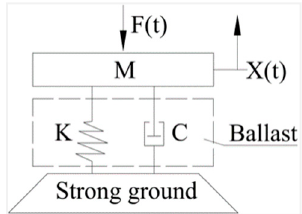
Figure 26. The single-degree-of-freedom (SDOF) idealization.